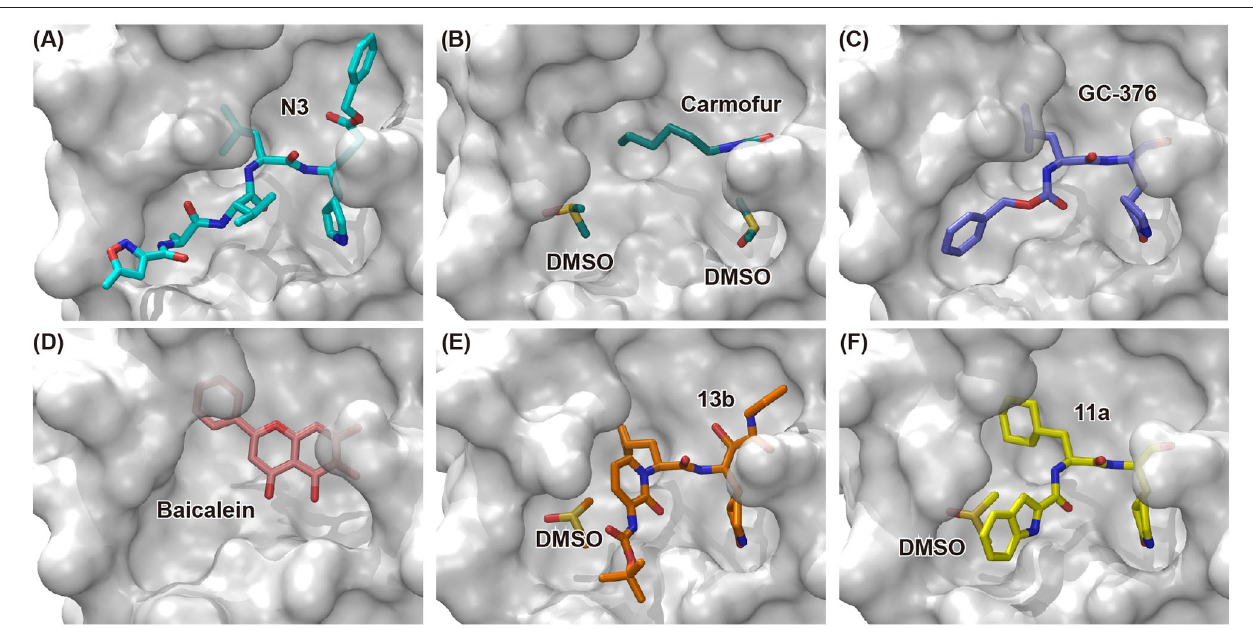
FIGURE 3 | Binding modes of newly identified inhibitors in complex with SARS-CoV-2 M pro . Inhibitors and co-factors are shown in stick: (A) N3 (PDB entry: 6LU7) (Jin et al., 2020a), (B) carmofur (PDB entry: 7BUY) (Jin et al., 2020b), (C) GC-376 (PDB entry: 6WTT) (Ma et al., 2020), (D) baicalein (PDB entry: 6M2N) (Su et al., 2020 ), (E) 13b (PDB entry: 6Y2F) (Zhang et al., 2020b), and (F) 11a (PDB entry: 6LZE) (Dai et al., 2020). The catalytic active site of SARS-CoV-2 M pro is shown in surface mode.